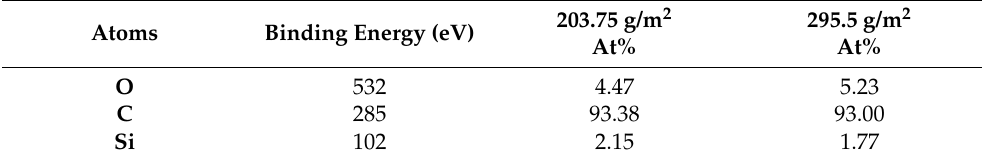
Table 1. Composition of 203.75 g/m 2 and 295.5 g/m 2 mats based on XPS survey